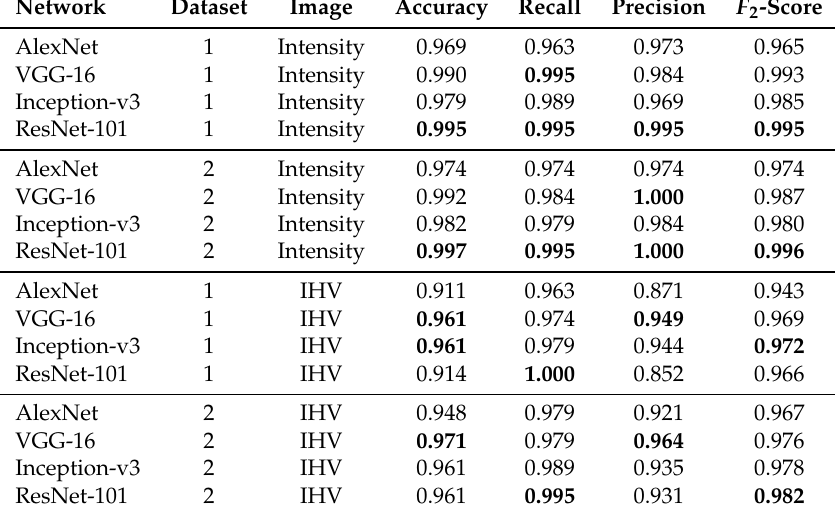
Table 2. Accuracy, recall, precision and F 2 -score for AlexNet, VGG-16, Inception-v3 and ResNet-101 trained on dataset 1 and 2 for intensity and IHV images. The highest scores for each dataset are shown in